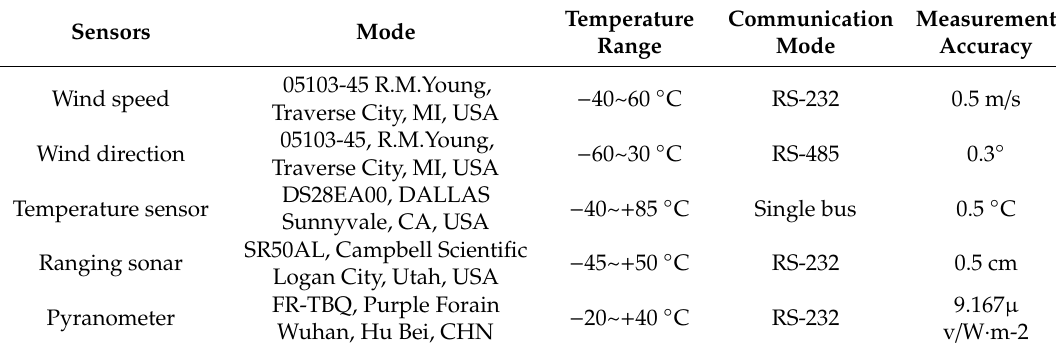
Table 2. Sensor information of the automatic weather station.